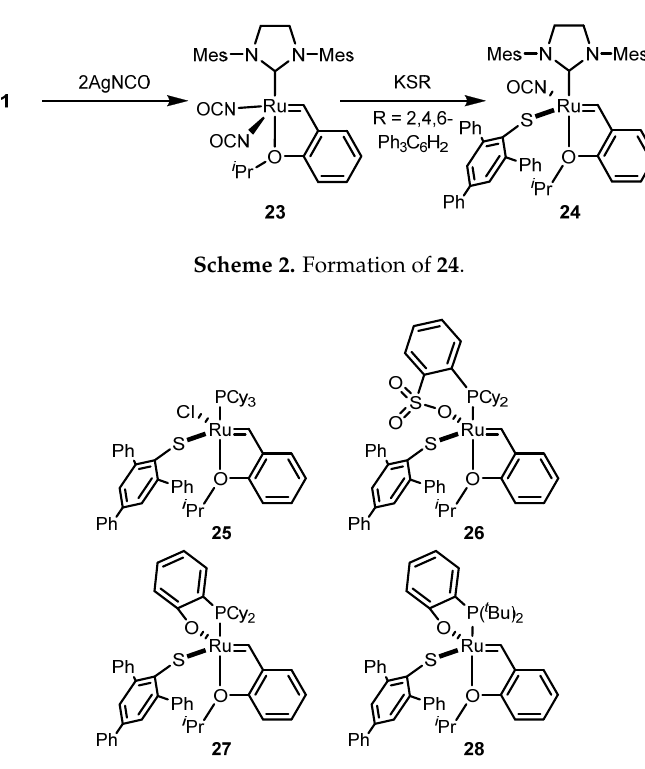
Figure 7. Phosphine and bidentate monothiolate catalysts evaluated.